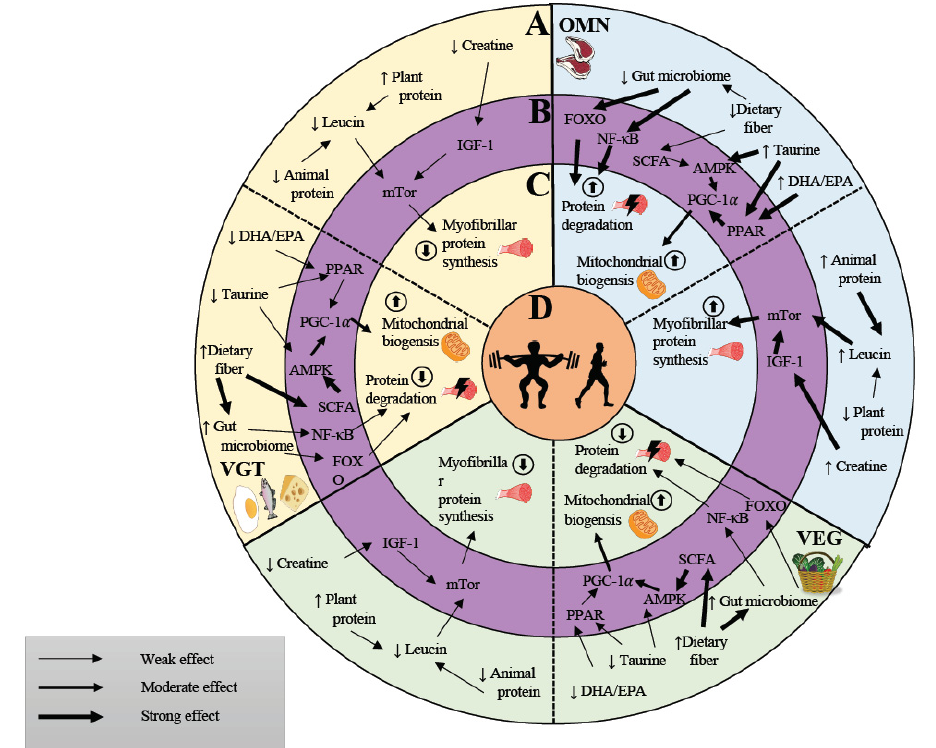
Figure 2. Influence of dietary properties on molecular signaling and muscular adaptation. ( A ): Vegan (VEG), vegetarian (VGT) and omnivorous (OMN) diets possess unique nutritional properties. This affects differential levels of polyunsaturated fatty acids, dietary fibers, plant- and animal-based protein sources, creatine and leucine. ( B ): Diet composition affects molecular signaling pathways. ( C ): Molecular signaling activates mitochondrial and myofibrillar protein synthesis and degradation and hereby modulates skeletal muscle adaptation and ( D ): exercise performance.Omnivorous diets (OMN, blue section) possess a lower amount of dietary fiber. This negatively affects the gut microbiome and reduces